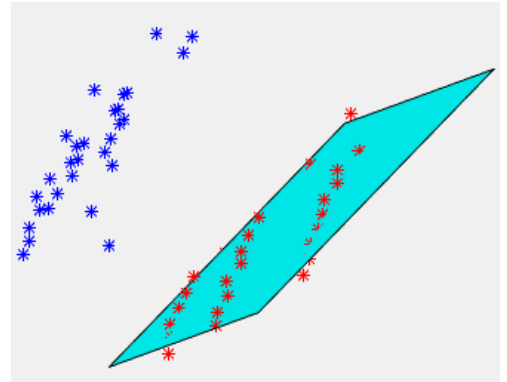
Figure 4- Plane fitted to inliers points (red) (blue points are outliers)